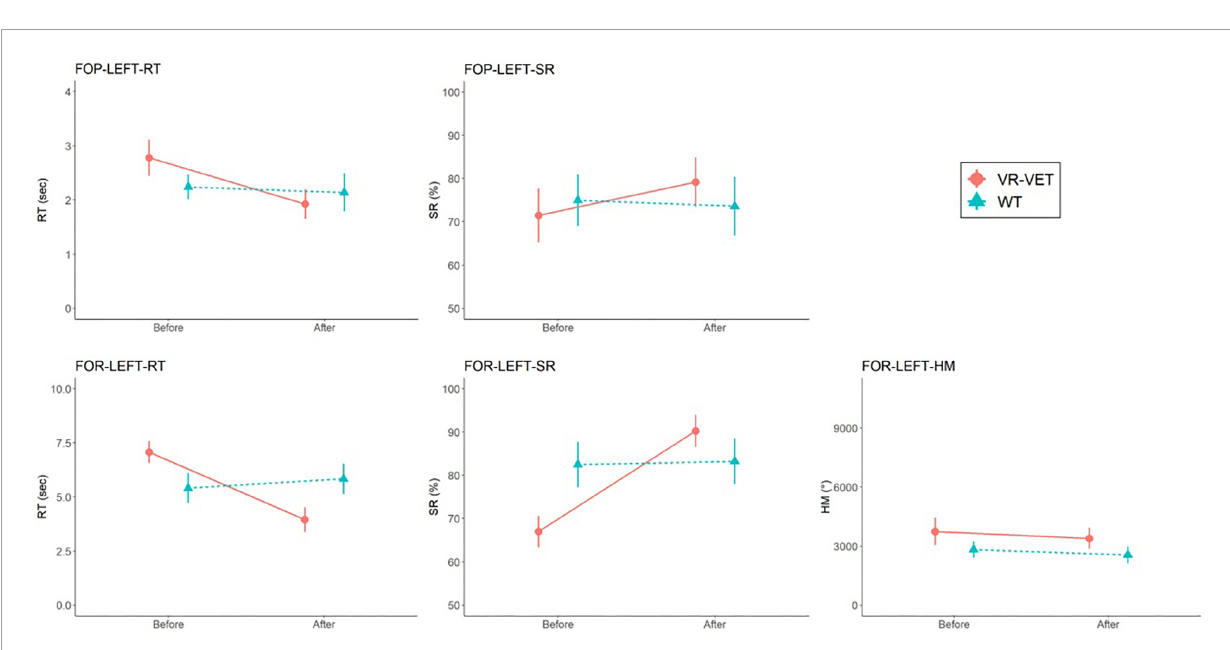
p < 0.001). Similarly, we identified significant interaction